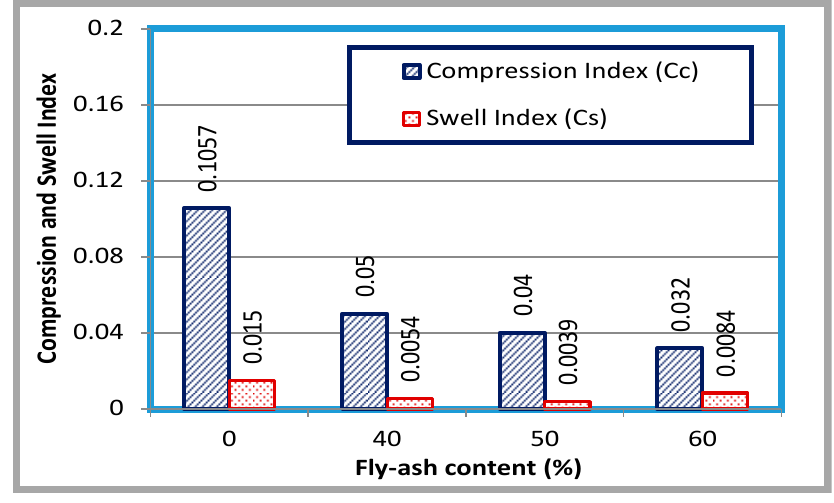
Figure 11. Variation of compression and swell indices with fly ash content .